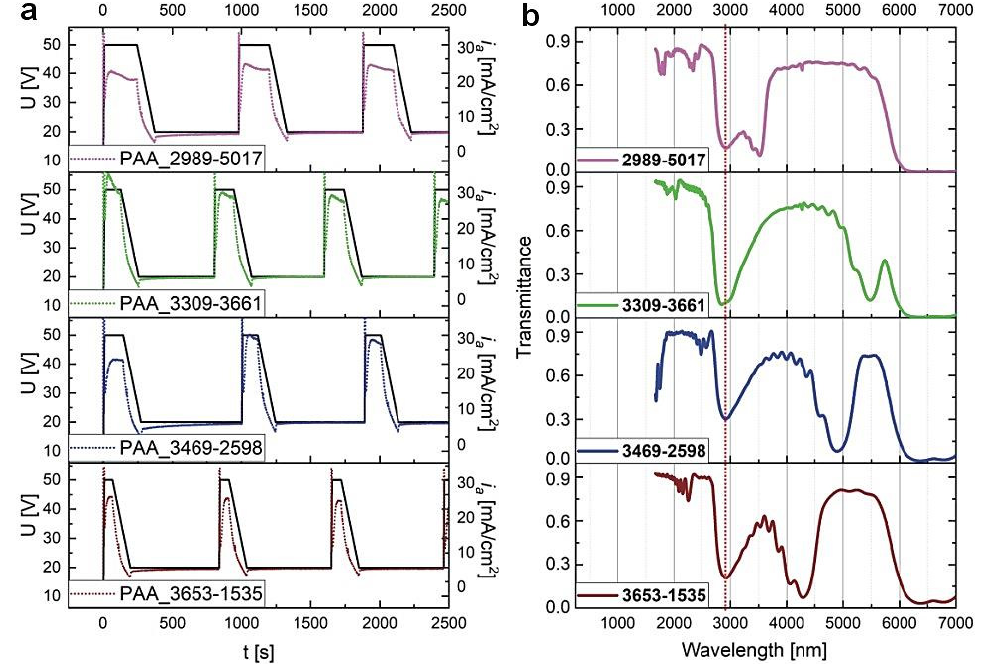
Figure 5. ( a ) The U(t) (black solid lines) i a (t) (dotted lines) curves recorded during pulse anodization at 30 °C with various C H and C L in [mC/cm 2 ] (the samples PAA_ C L -C H ) and other parameters as follows: U H = 50 V, U L = 20 V, U H ->U L drop rate = 0.234 V/s, 20 cycles; ( b ) the corresponding transmission spectra recorded for the samples after t p = 60 min.